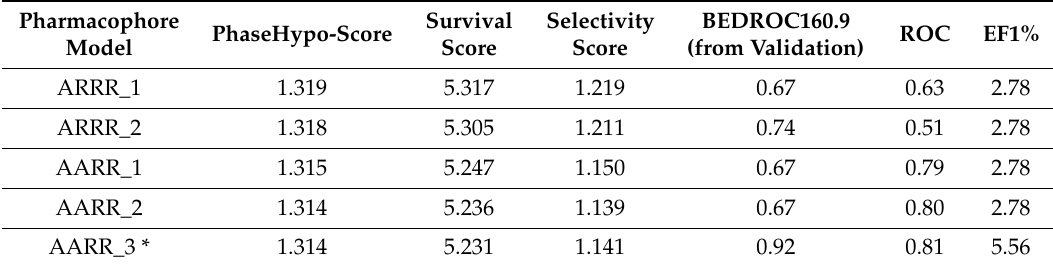
Table 9. Top 5 pharmacophore hypotheses for the 1,2,3-benzotriazole set. A–acceptor group; H–hydrophobic group; R–aromatic group.